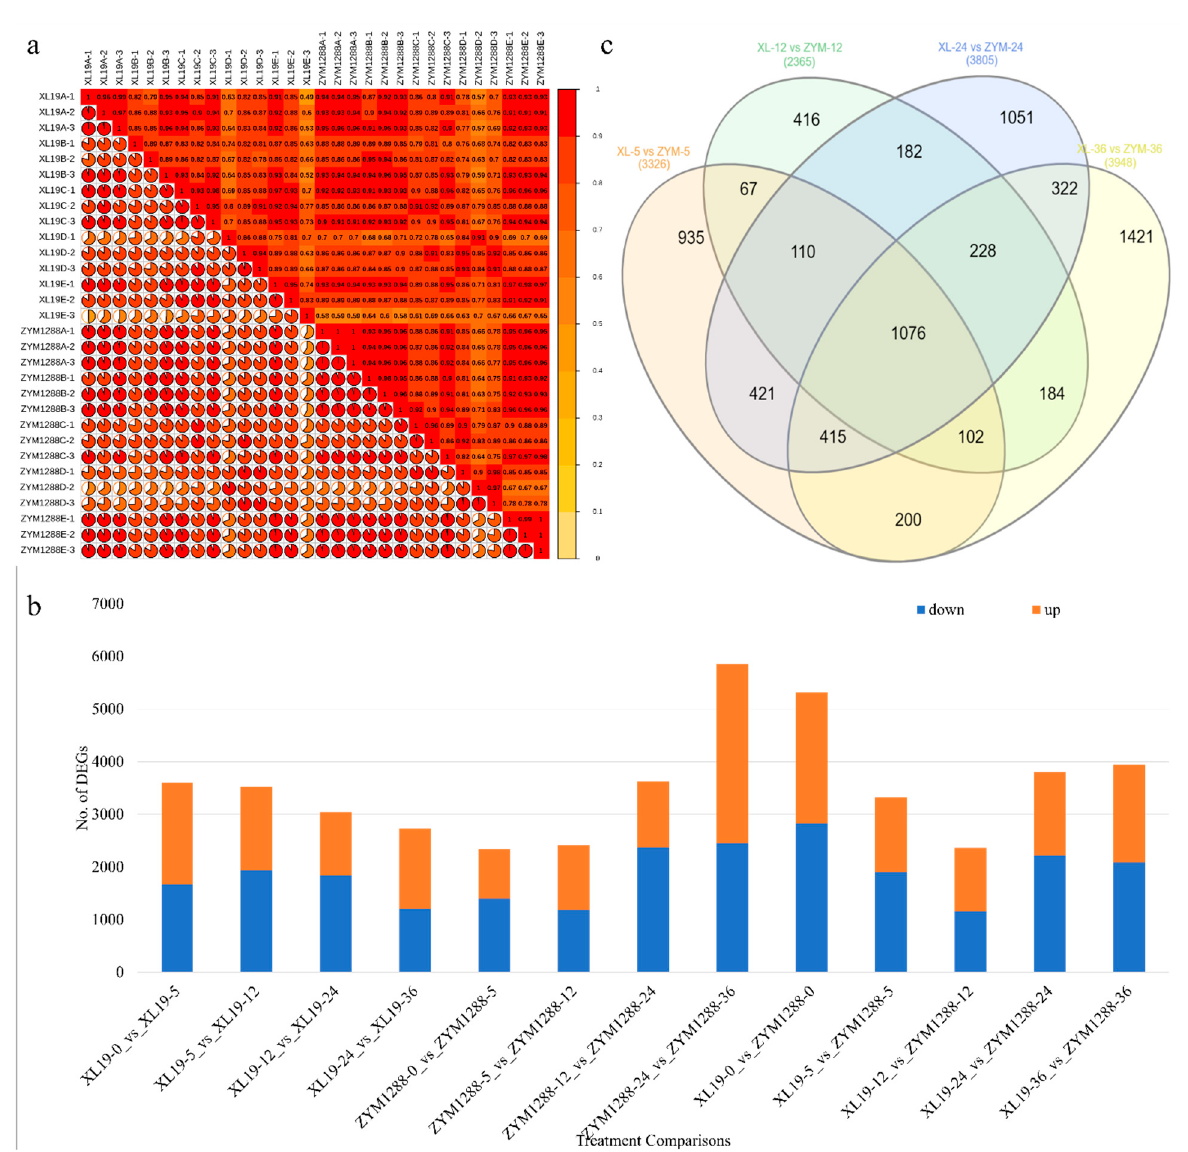
Figure 3. ( a ) Pearson correlation coefficient between the expression of biological replicates, ( b ) number of differentially expressed genes between different treatment comparisons, and ( c ) venn diagram of differentially expressed genes at different time points in susceptible (XL19) and resistant (ZYM1288) hulless barley. A, B, C, D, and E in figure panel a represent 0, 5, 12, 24, and 36 hpi, respectively.